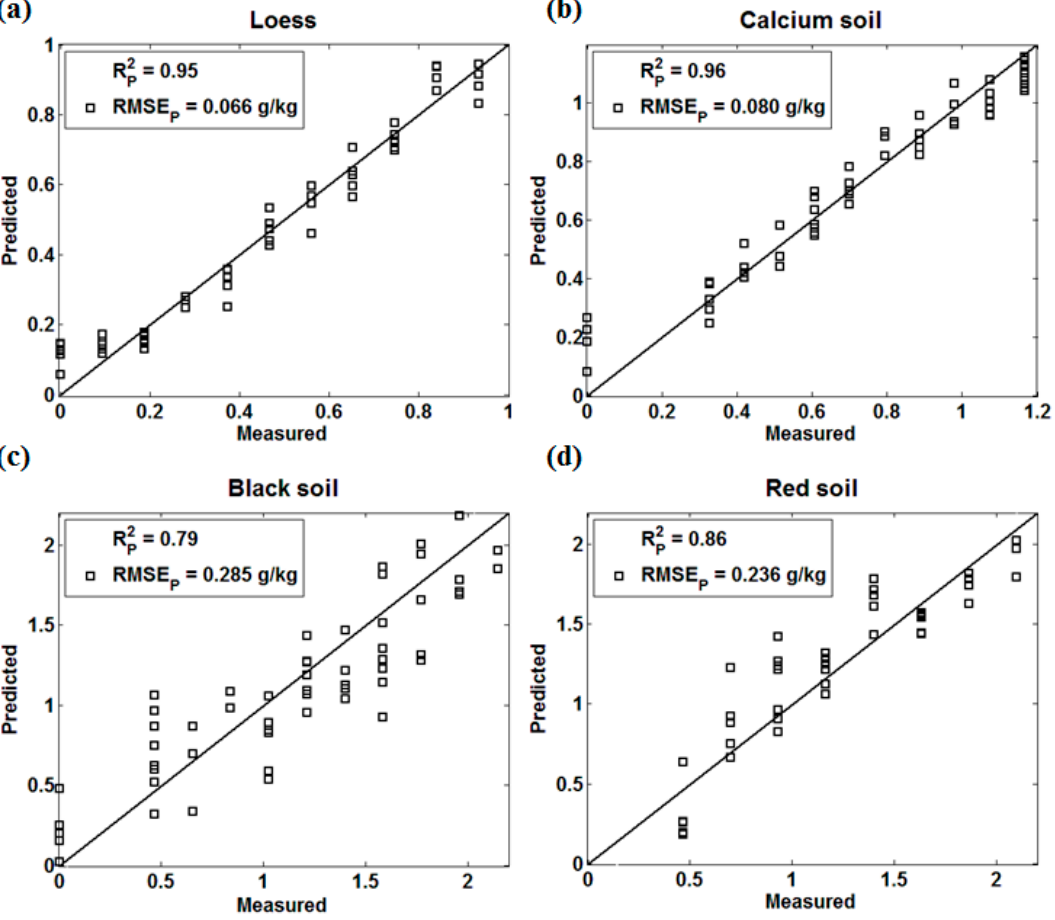
Figure 3. The Partial Least Squares (PLS) effect of four kinds of soils. ( a ) Loess; ( b ) Calcium soil; ( c ) Black Soil; ( d ) Red soil.